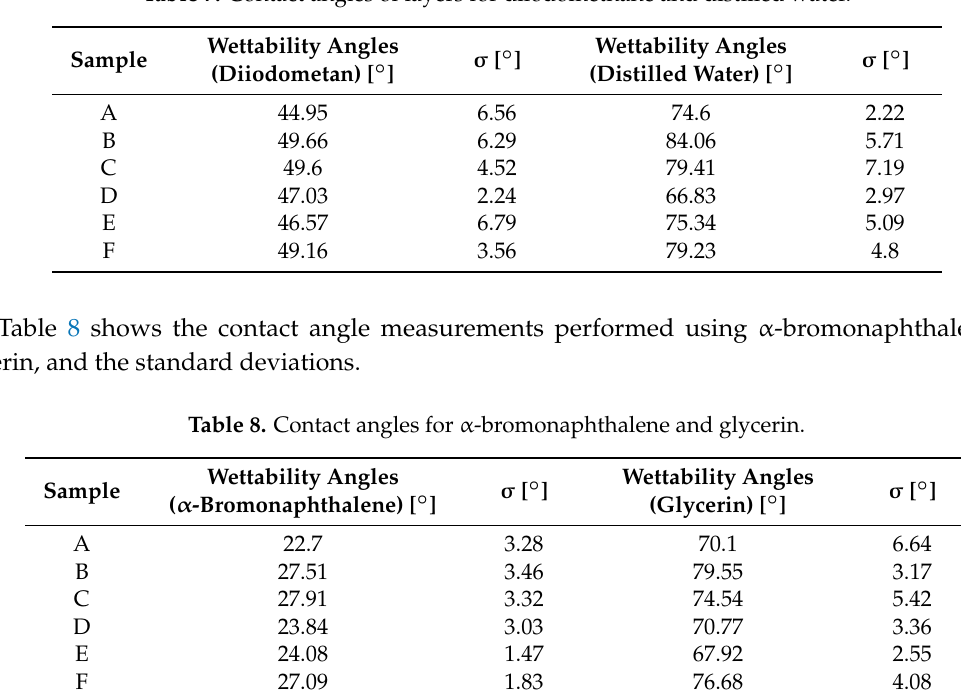
Table 7. Contact angles of layers for diiodomethane and distilled water.